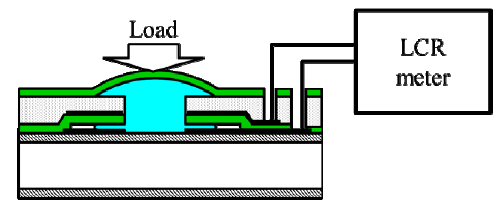
Figure 9. Schematic of measurement